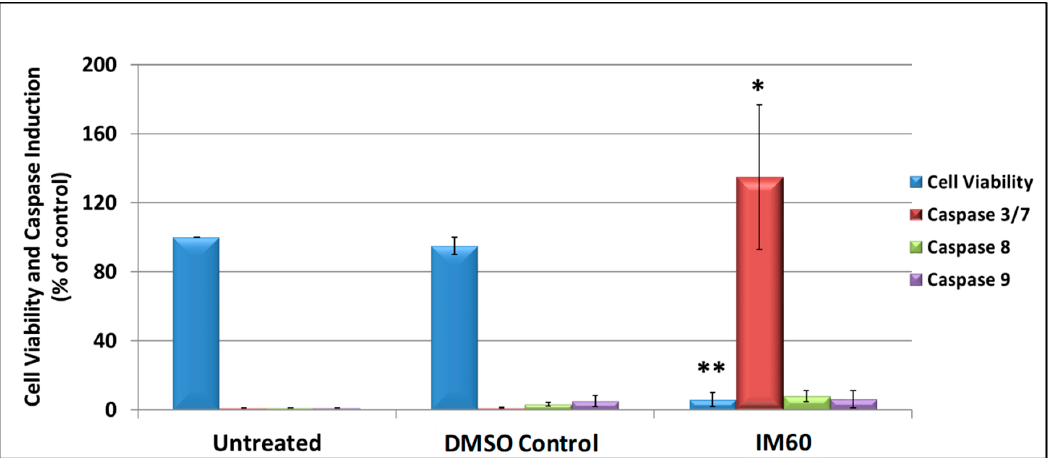
Figure 8. MCF-7 cells were treated with 425 µM of IM60 for 6 h and then assayed for cell viability and induction of different caspase enzyme activities (3/7, 8, and 9). * indicates statistically significant differences between the DMSO-treated and IM60-treated samples (* p < 0.05 but > 0.01; ** p < 0.01). The “DMSO control” contains the same amount of DMSO as present in the IM60-treated sample.